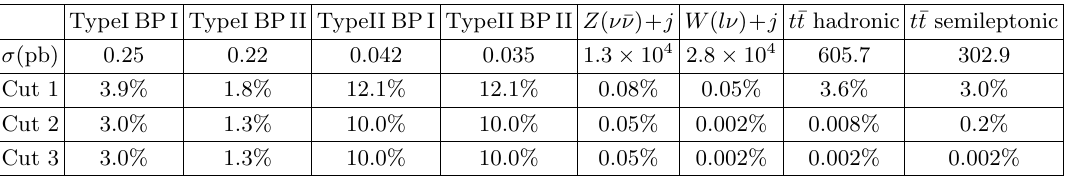
Table 3 . Signal and background e(cid:14)ciencies after applying various cuts for the gluon fusion pro- duction channel at 14 TeV with L = 3000 fb (cid:0) 1 . The cross sections are calculated at NLO. benchmark point, for 14 TeV LHC with 3000 fb (cid:0) 1 . The signi(cid:12)cance S is de(cid:12)ned as